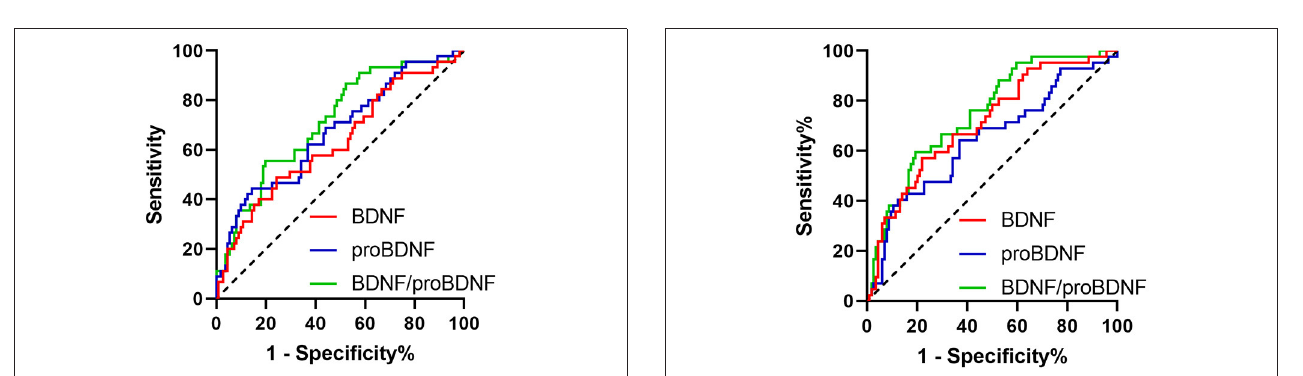
FIGURE 1 | ROC curves of proBDNF, mBDNF, and mBDNF/proBDNF in the initial diagnosis of PD.